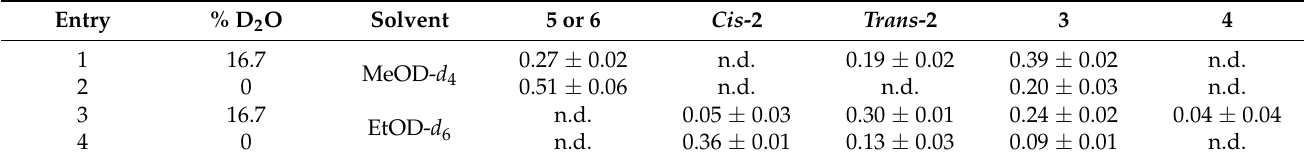
Table 3. Product yields from the conversion of CHN 1 with varying % D 2 O in alcoholic solvents. Yields are reported as averages and standard deviations obtained from triplicate measurements or not determined (n.d.) because the signal was below